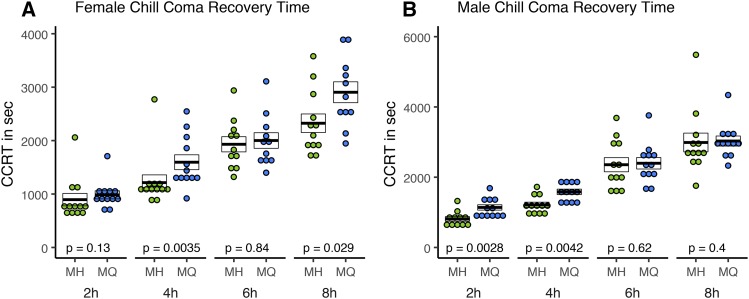
Chill coma recovery time: Phenotypes were measured for adult female (A) and male (B) flies exposed to cold for 2, 4, 6, and 8 hr. Each point depicts the recovery time (stand up) from cold shock. Crossbars represent mean ± SE, with p-values corresponding to a Wilcoxon test on MH vs. MQ for each cold treatment. Sample sizes are n = 11 or n = 12 vials.